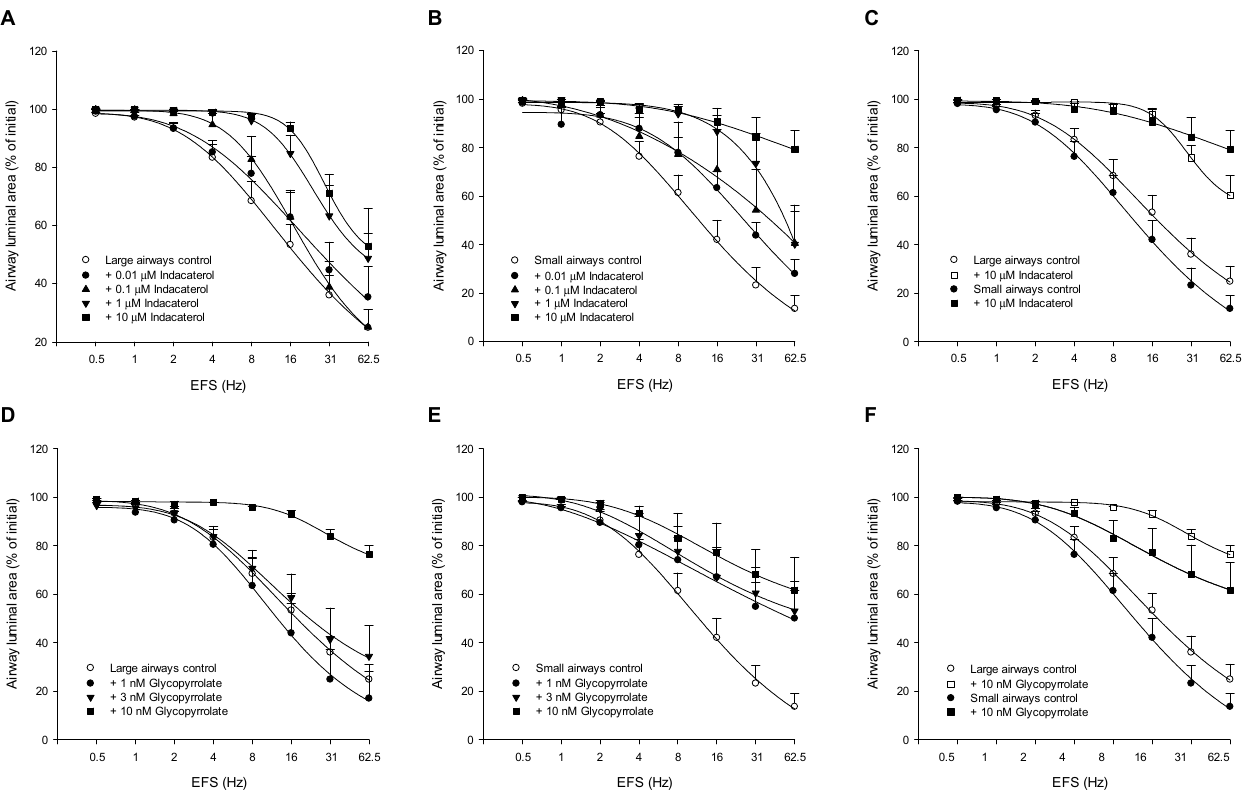
Figure 2. The effect of the β 2 -agonist indacaterol ( A – C ) and the anticholinergic glycopyrrolate ( D – F ) on EFS-induced constrictions of large ( A , D ) and small ( B , E ) airways in guinea pig lung slices. Comparison of maximal drug effectiveness on large and small airways is shown in panels C and F. Lung slices were incubated with increasing concentrations of indacaterol (0.01, 0.1, 1 and 10 µ M) or glycopyrrolate (1, 3 and 10 nM) and the constriction of large (>150 µ m) and small (<150 µ m) airways to increasing frequencies (0.5–62.5 Hz) of EFS was determined by measuring the luminal area as a percentage of baseline. Data are represented as means ± SEM of 2–10 guinea pigs (see also Table 2). Table 2. Effects of indacaterol and glycopyrrolate on EFS-induced airway constriction of large and small airways in guinea pig lung slices.